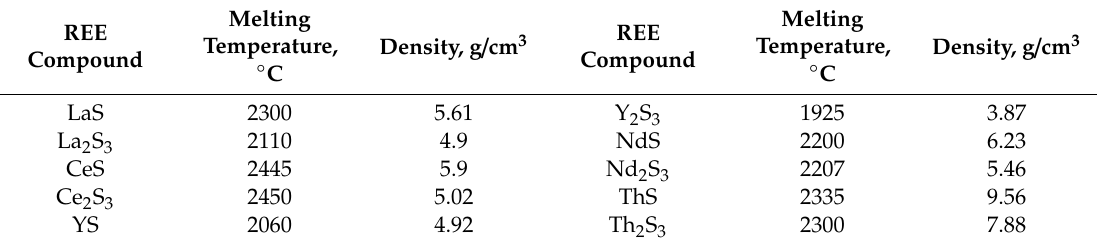
Table 3. Physical properties of refractory sulphides of REEs